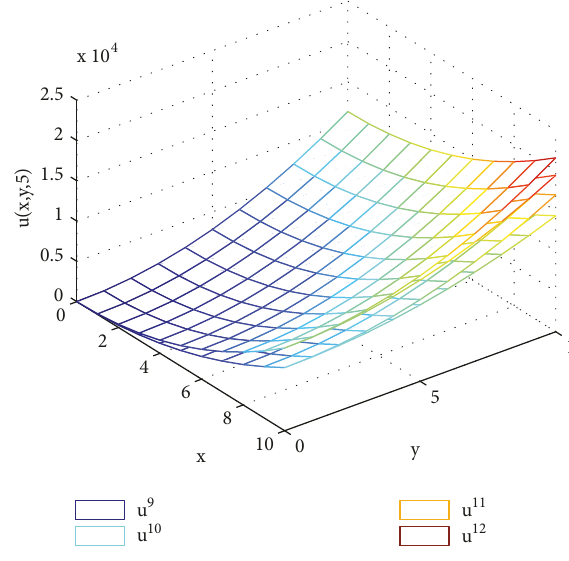
Figure 7: The approximate solutions 𝑢 9 , 𝑢 10 , 𝑢 11 , and 𝑢 12 of (49) at 𝑡 = 5 with 𝛼 = 1/2 .